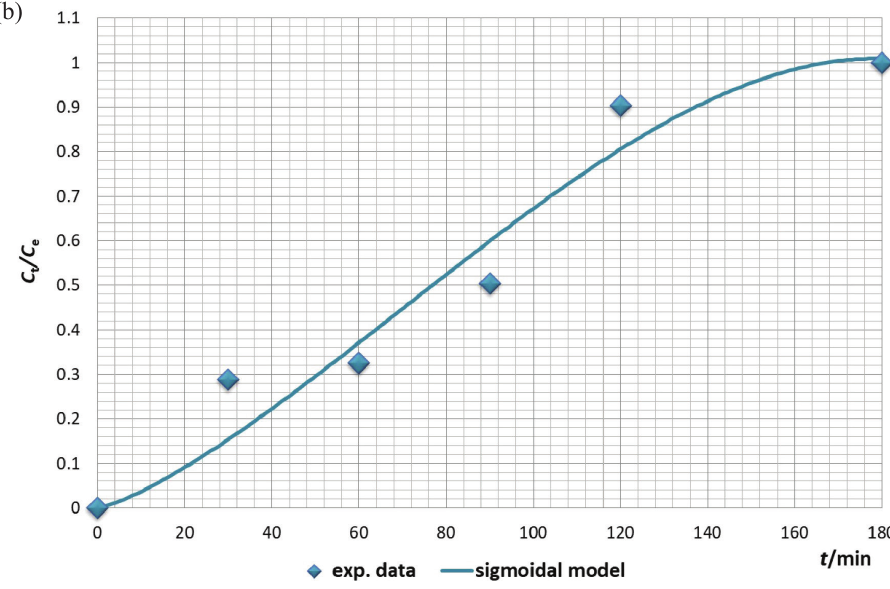
Fig. 11 – Applicability of the sigmoidal model to the experimental data for vitamin E release from